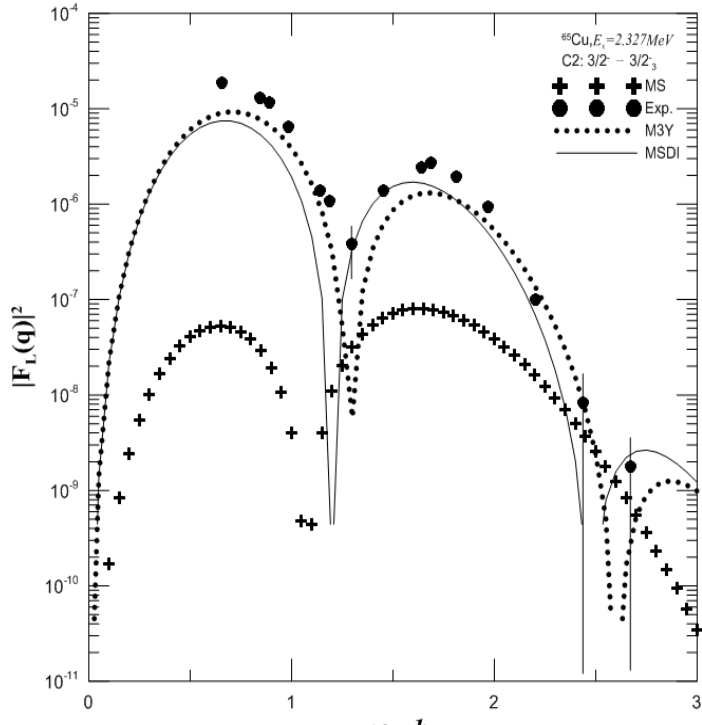
Fig.4: Inelastic longitudinal form factors for C2 transition 3/2 -  using MSDI and M3Y interactions with core-polarization effects, through particle-hole excitations up to 6ћω. The experimental data are taken from Ref.